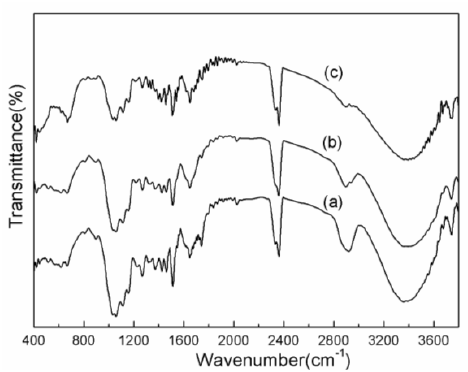
Figure 1. Fourier transform infrared spectroscopy (FTIR) spectra of the pretreated wood powder ( a ) wood powder without treatment; ( b ) wood powder pretreated by NaOH; ( c ) wood powder pretreated by 1.00 mol · L −1 FeCl 3 and aqueous ammonia.